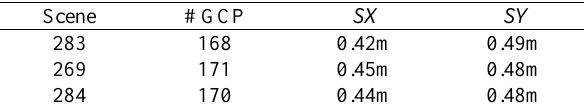
Figure 3. Imaging configuration of the used image set